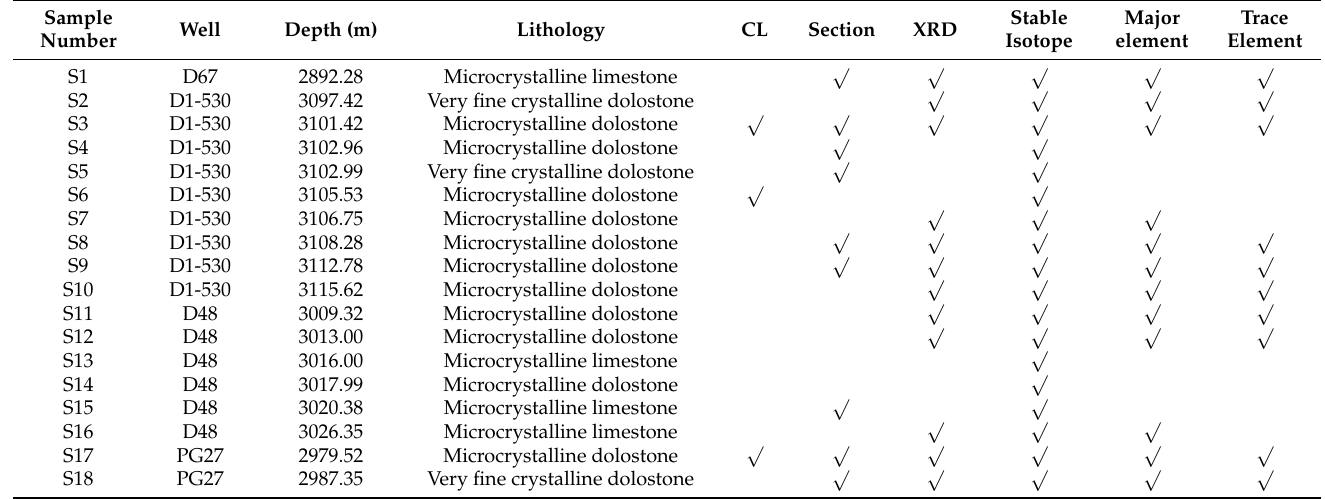
Table 1. The sample information and test items in the